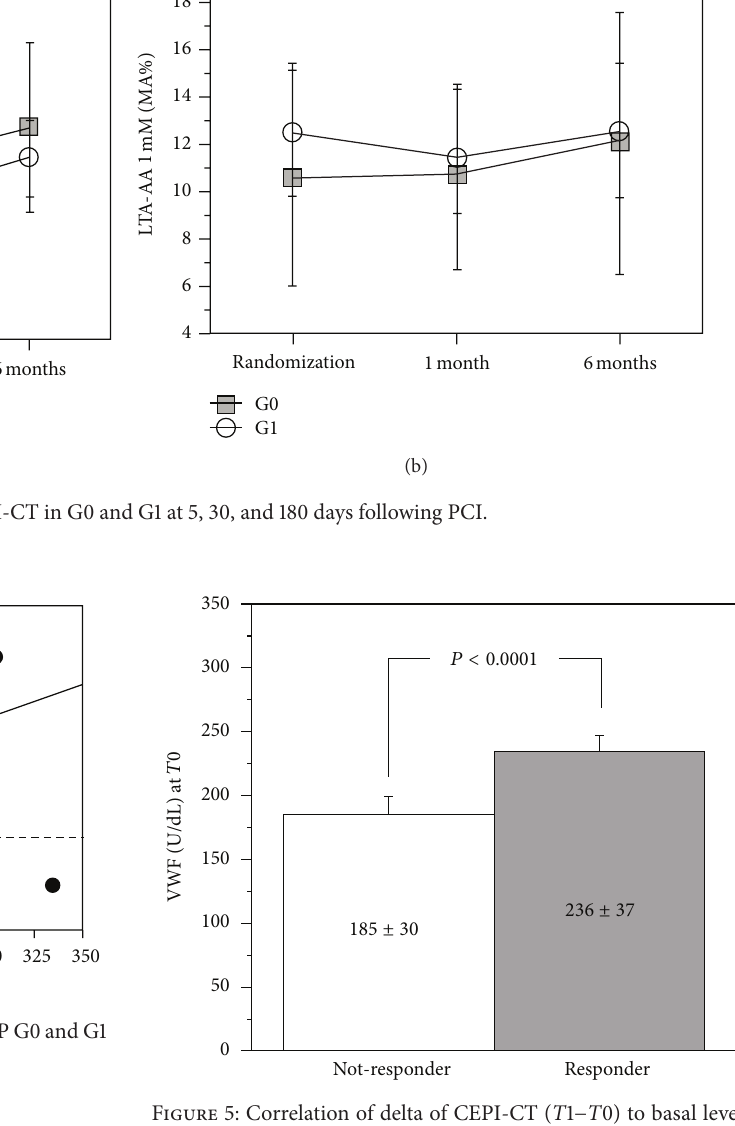
Figure 5: Correlation of delta of CEPI-CT ( T 1 − T 0) to basal levels of VWF and